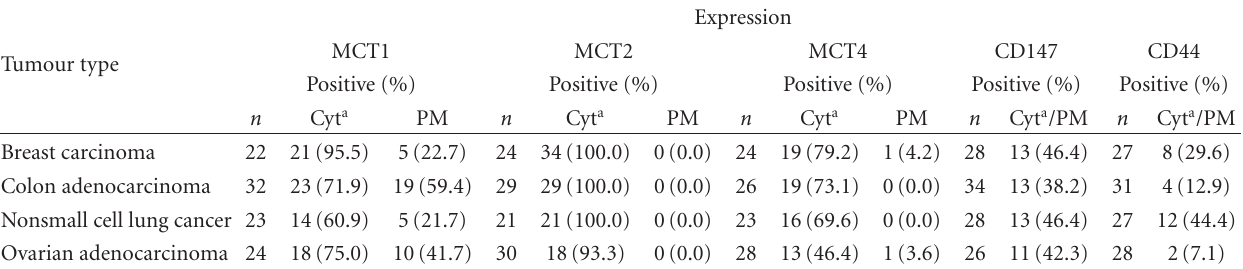
Table 1: Frequency of MCTs, CD147, and CD44 expressions in tumour samples.